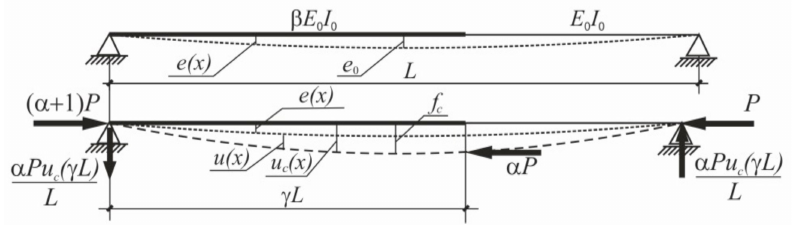
Figure 10. Deflections of the initially curved rod. The case with additional force in the column’s span. The compression resistances of columns considered in Section 2 will be determined now using derived formulae. Resistances of columns loaded at ends and loaded addi- tionally at the section of the sudden cross-section change, calculated from Formulas (30) and (31), are presented in Tables 7 and 8 and labeled as P prop Results of geometrically and Rd materially nonlinear analyses, carried out by means of the Abaqus system, are presented in these tables as well. P num are the maximum values of force on the load-displacement paths Rd obtained for the initial bow imperfection of amplitude L /750. Table 7. Compressive resistance in [kN]. Column’s Case.